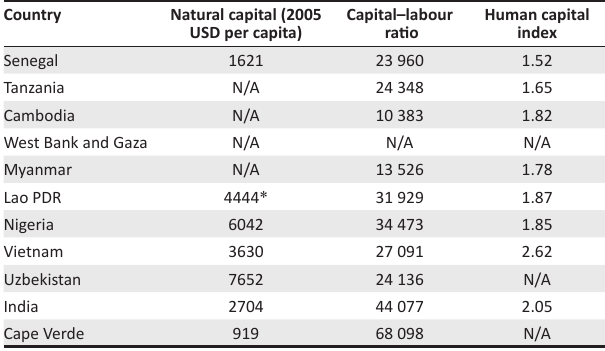
TABLE 3: The endowment structures in 2014; (the estimates of natural capital are for the year 2005). Country Natural capital (2005 Capital–labour USD per capita)